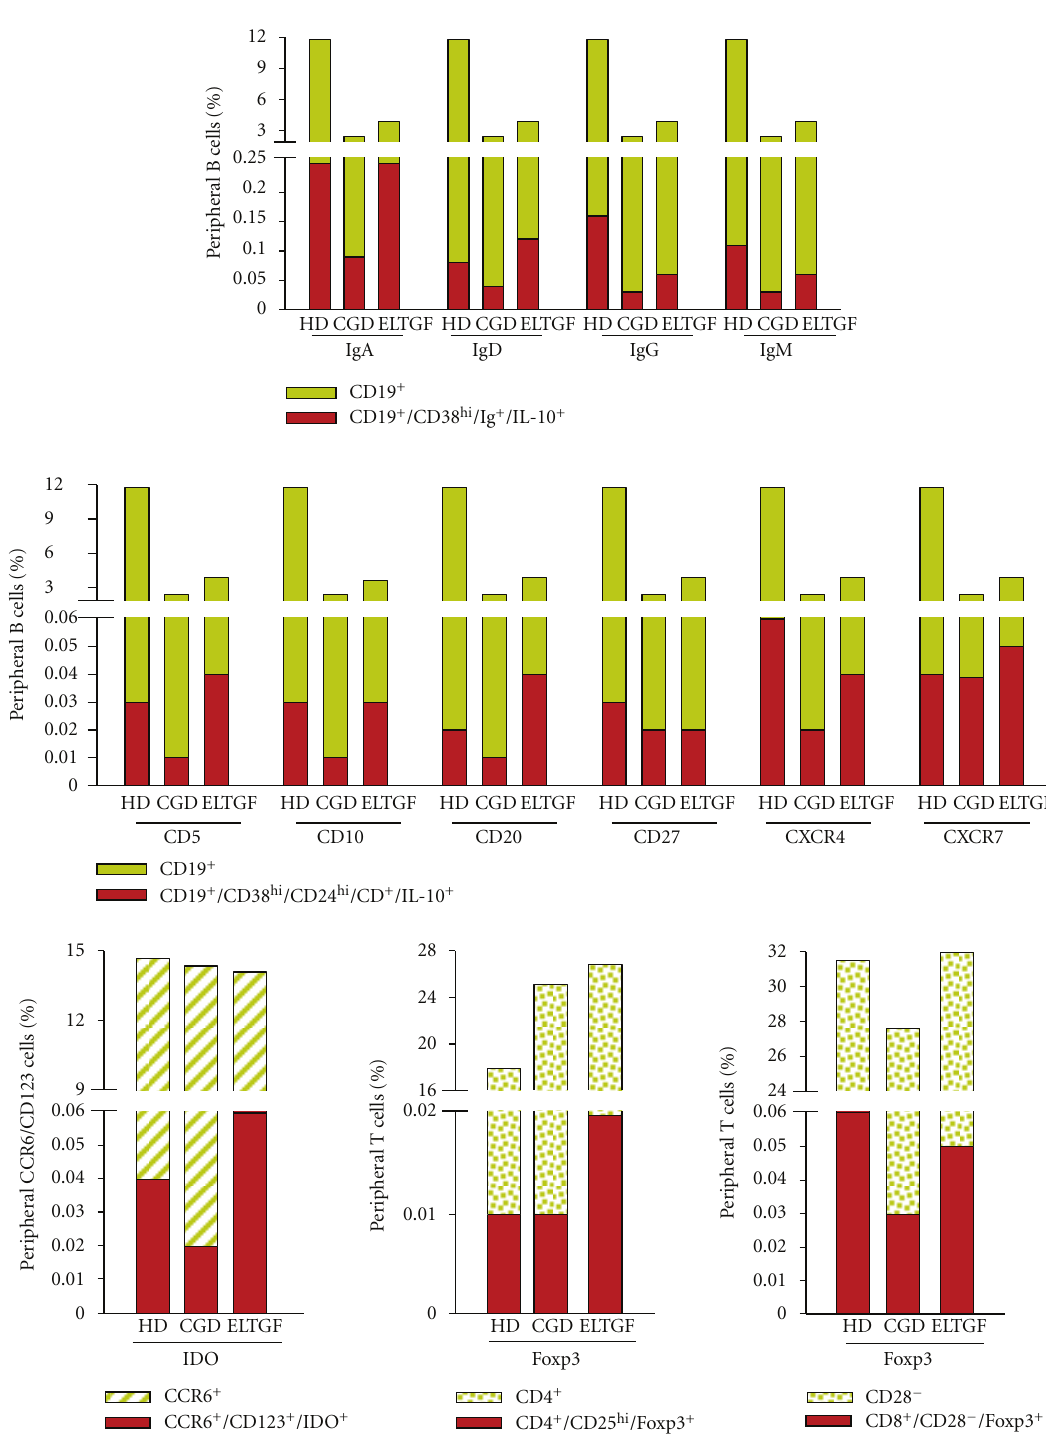
Figure 1: Percentage of IL-10-producing B cells, IDO + -, and Foxp3 + -circulating cells were calculated from percentage of CD19 + , CCR6 + , CD4 + , or CD28 − cells, respectively, obtained following positive selection. HD: healthy donor, CGD: chronic graft dysfunction, and ELTGF: excellent long-term graft function under